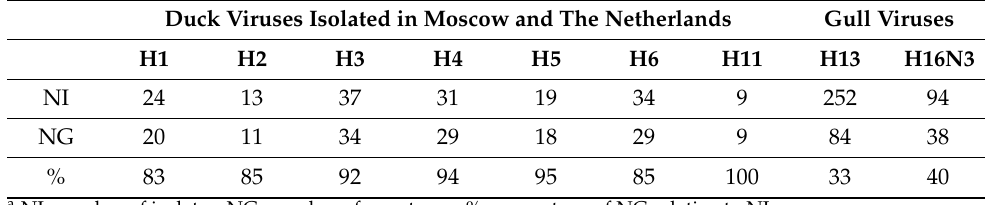
Table 2. Diversity of influenza viruses of different subtypes a . Duck Viruses Isolated in Moscow and The Netherlands Gull Viruses H1 H2